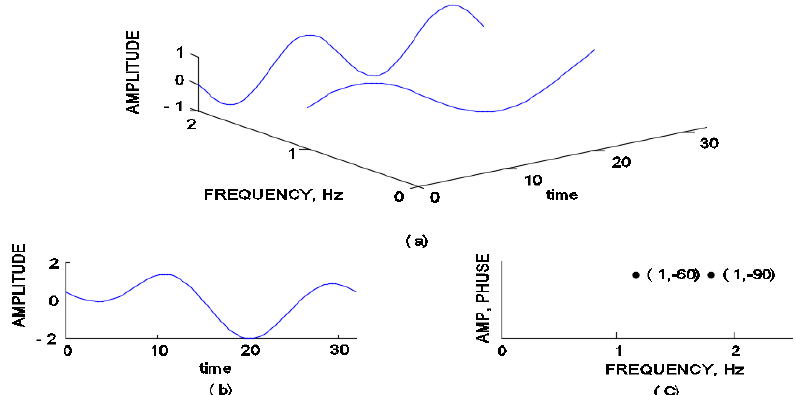
Figure 1. Representation of a signal in the time and frequency domains. ( a ) Two components of the same signal; ( b ) Time-domain representation; ( c ) Frequency-domain representation, as shown in [15].